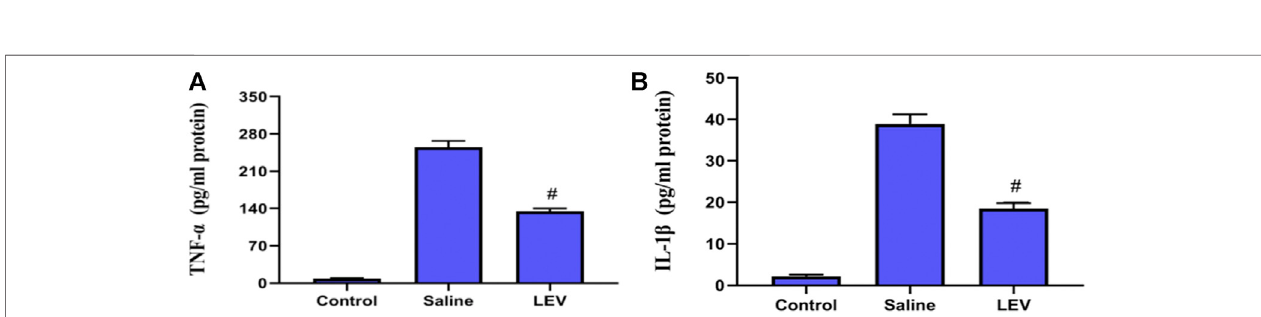
FIGURE6| Levetiracetam(LEV)suppressestheproductionofIL-1 β andTNF- α inthecerebralcortexofrats14daysafterischemicbraininjury. (A , B) Interleukin-1 β (IL-1 β ) and tumor necrosis factor- α (TNF- α ) concentrations in the cerebral cortex were measured by enzyme-linked immunosorbent assays (ELISA). N (cid:1) 12 per group. # p < 0.01 compared to the saline and control